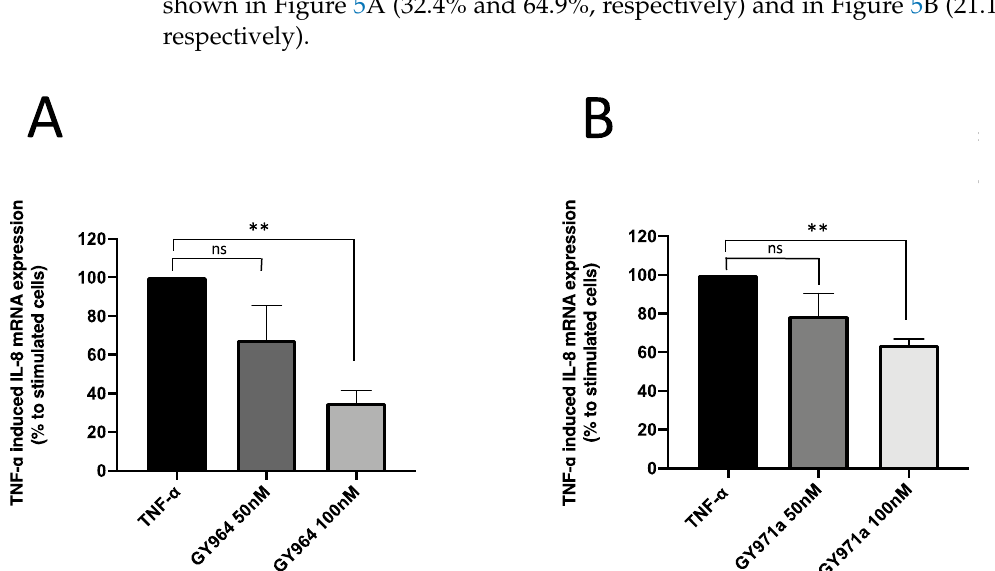
Figure 5. Effect of TMA analogues on IL-8 expression in TNF-α-stimulated IB3-1 cells. ( A , B ) Percent variations of IL-8 mRNA accumulation induced by GY964 (4-PhDMA) and GY971a (pANDMA) TMA analogues at different concentrations (50 and 100 nM) with respect to TNF-α-stimulated cells (mean values ± SD from three independent experiments). Statistics were performed by ANOVA, using Graph Pad Prism 9.0, where statistical significance at the levels of p < 0.01 (**) is reported, together with non-significance (ns).